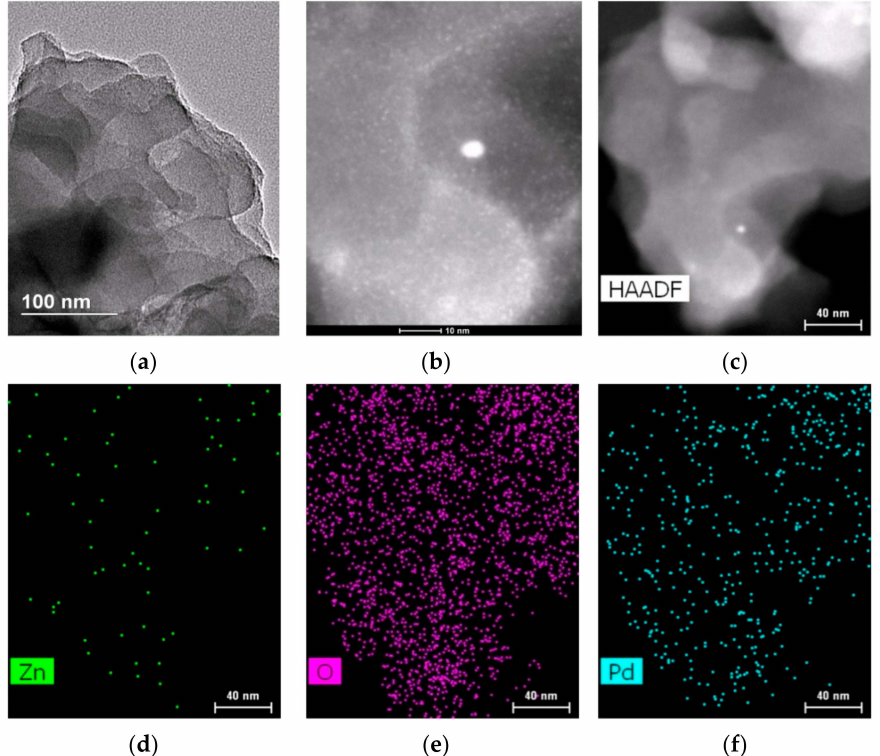
Figure 5. Bright-field ( a ) and dark-field ( b , c ) (scale is 10 nm for ( b ) and 40 nm for ( c )) STEM images of the initial (unreduced) sample 1%-PdZn/HPS and EDX mapping of Zn ( d ), O ( e ), and Pd ( f ) (scales 40 nm).